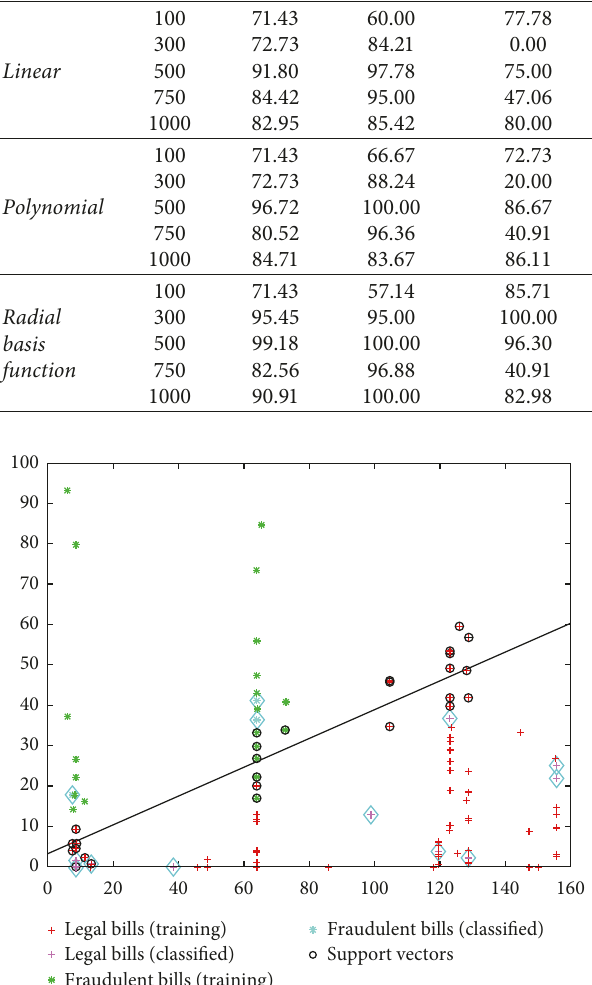
Figure 11: Linear SVM on a sample claims